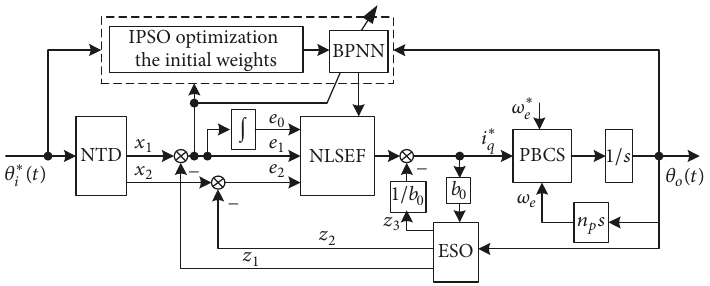
Figure 5: Diagram of the improved ADRC-PBC controller.